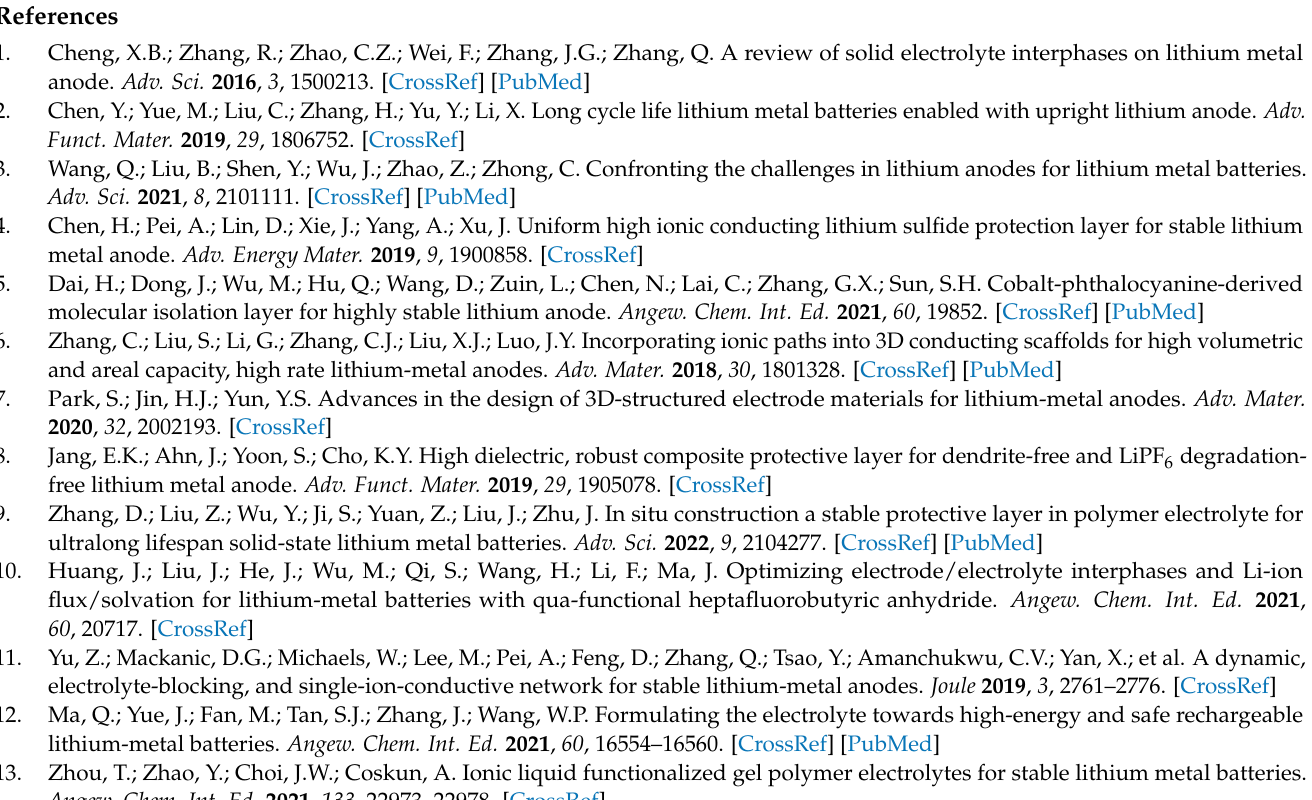
density of 1 mA cm − 2 with a capacity of 1 mAh cm − 2 ; Figure S6: The surface morphology of (a) the MF-Li anode and (b) the pristine Li anode after plating at the current density of 0.5 mA cm − 2 for 2 h; Figure S7: Cross-sectional view SEM images of (a) the MF-Li anode and (b) the pristine Li anode after 50 cycles in the symmetrical cells; Figure S8: Voltage profiles of MF-Li and pristine Li anodes in the Li||Li symmetric cell at the current density of 5 mA cm − 2 under a capacity of 1 mAh cm − 2 (insets are detailed voltage profiles); Figure S9: The voltage profiles of the Li||LFP cell with the pristine Li anode at different cycles; Figure S10: Rate performance of Li||LFP paired with the MF-Li and pristine Li anodes; Figure S11: Cycling stabilities of full cells with the two anodes under the conditions of 5.4 mg cm − 2 and 1 C; Figure S12: CV curves of Li||LFP cell with the pristine Li anode at a scan rate 0.1 mV s − 1 ; Table S1: Comparison of cycling stability of our work with the reported artificial SEI in symmetric cells and Li||LFP full cells. References [39–50] are cited in the supplementary